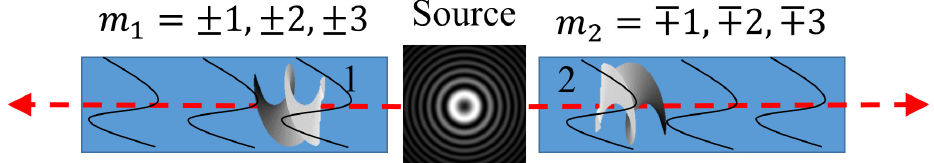
Figure 1. Sketch of a thought experiment involving bi-photon propagation through independent turbulence paths 1 and